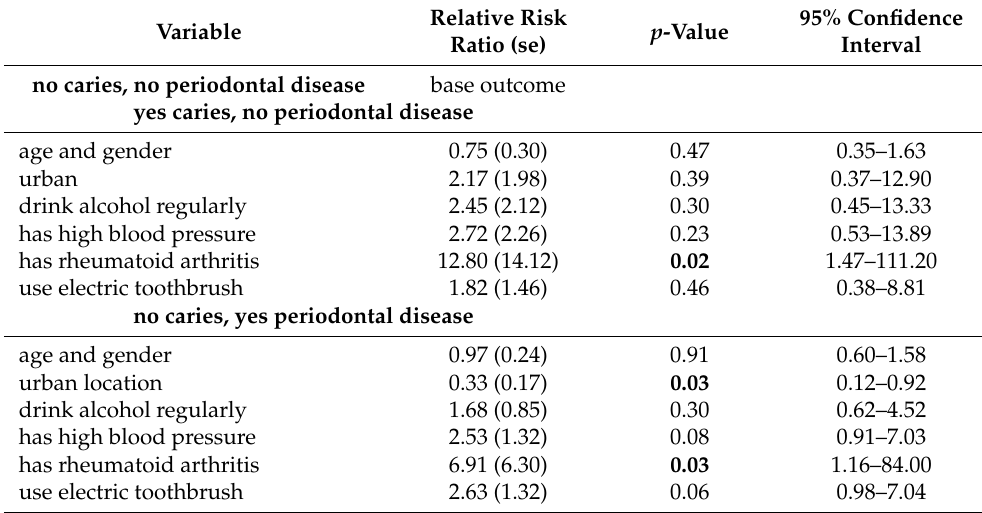
Table 3. Multinomial logistic regression